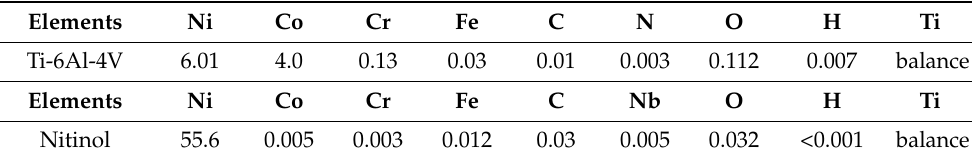
Table 1. Composition of base metals (wt %).